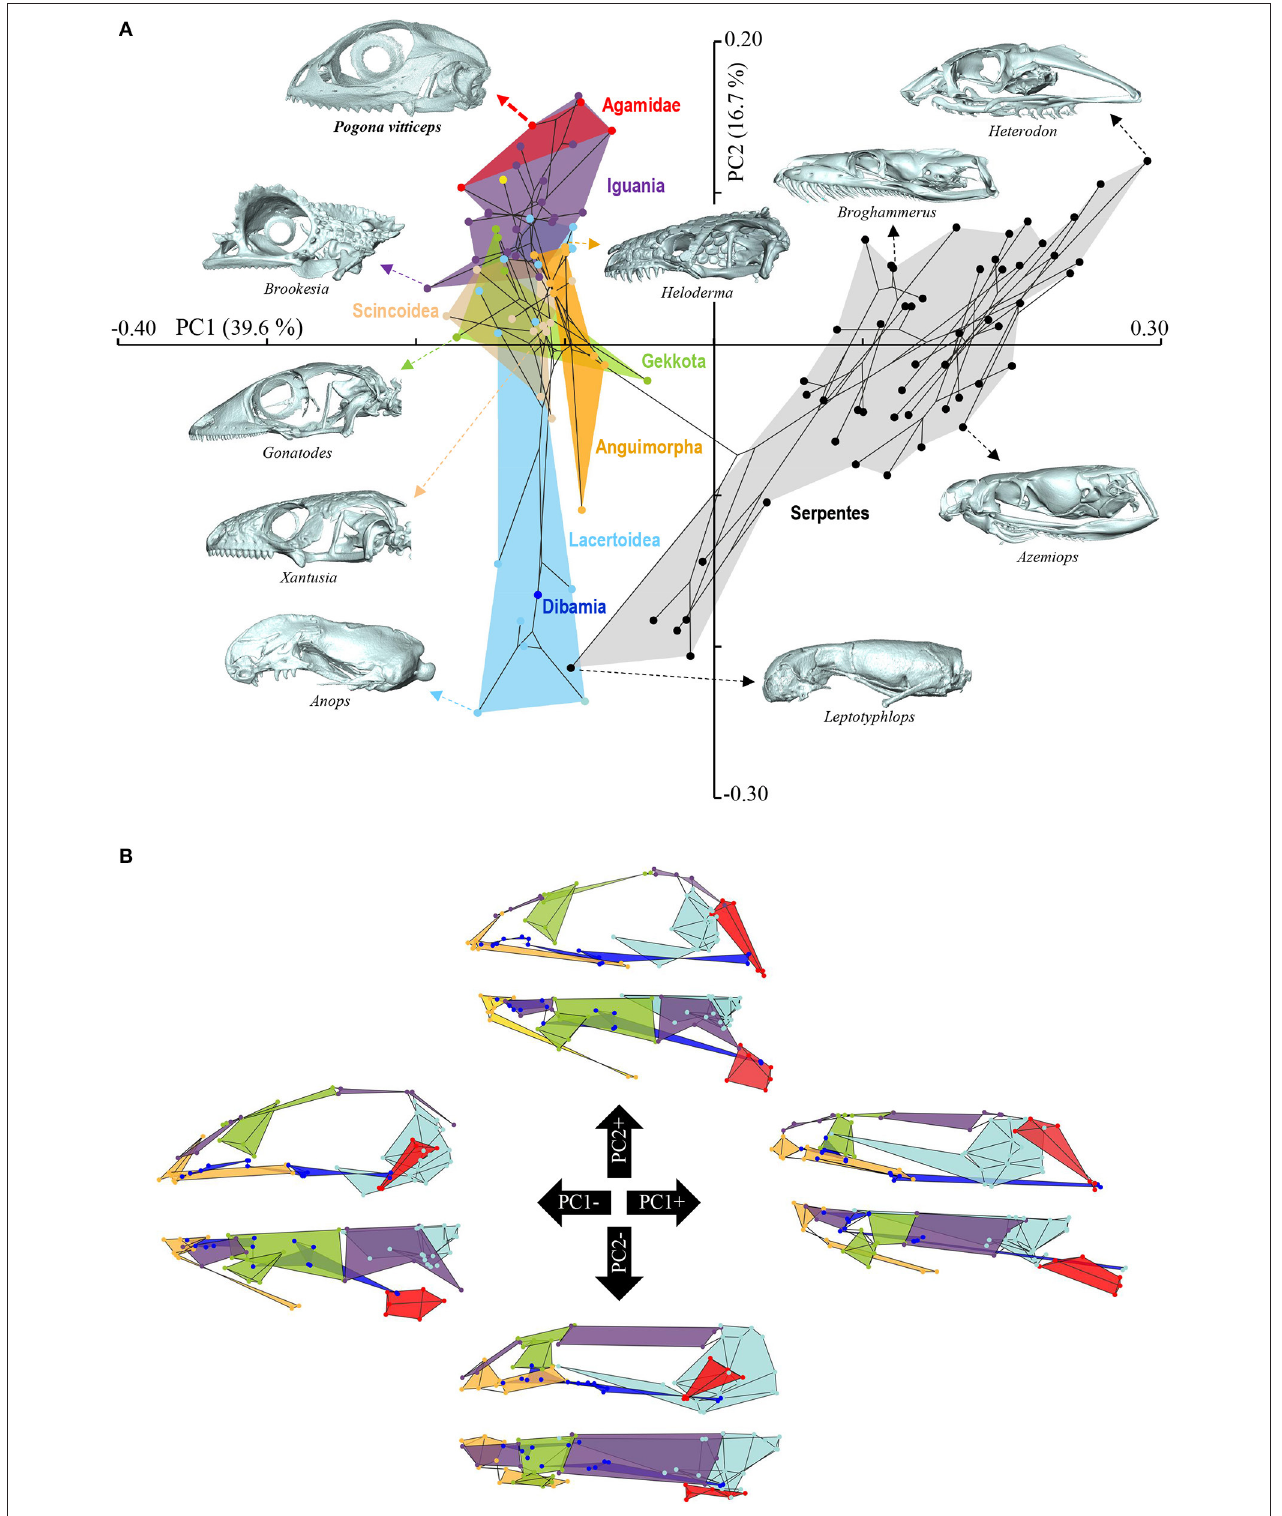
FIGURE 4 | Principal component analysis of cranium shape variation in squamates. (A) Phylomorphospace showing the cranium shape distribution of major groups of squamates: Dibamia (dark blue tip node), Gekkota (green shading and tip nodes), Scincoidea (brown shading and tip nodes), Lacertoidea (light blue shading and tip nodes), Anguimorpha (orange shading and tip nodes), Iguania (purple shading and tip nodes), Agamidae (red shading and tip nodes), and Serpentes (gray shading